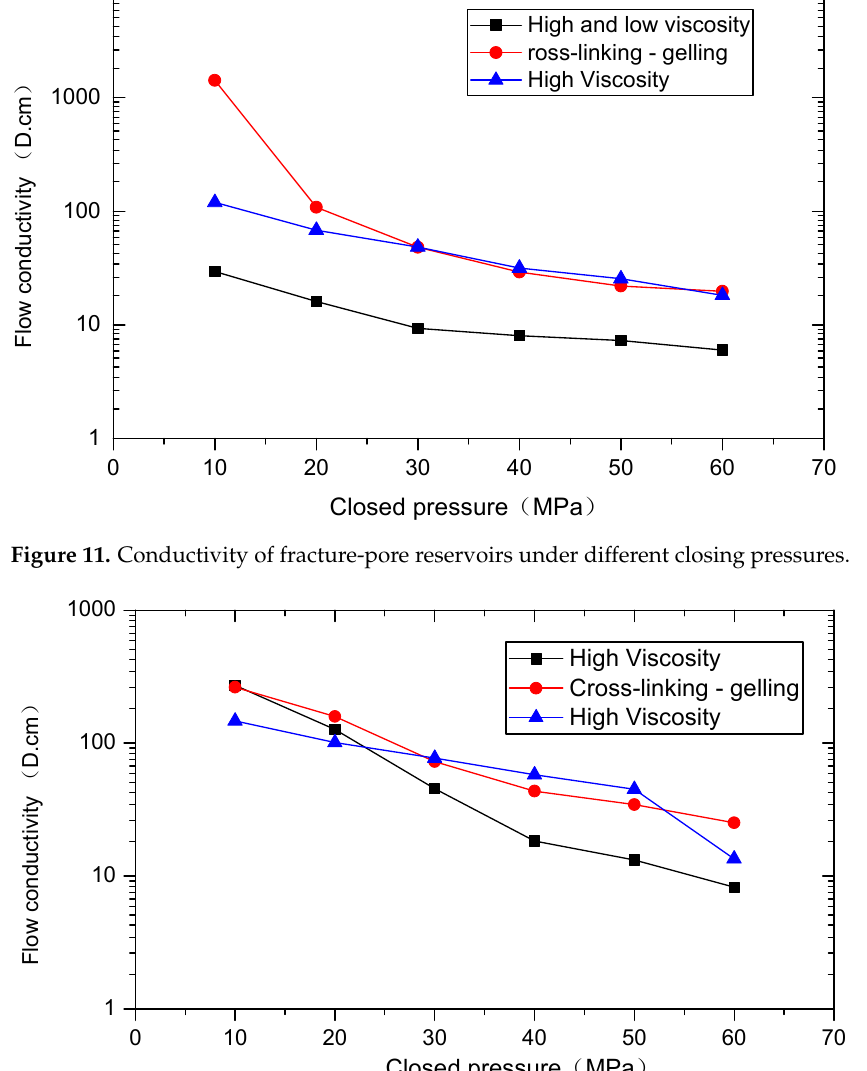
Figure 13. Conductivity of porous reservoirs under different closing pressures.